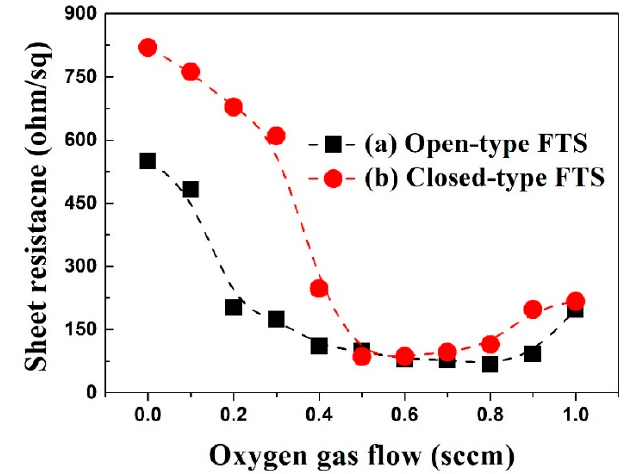
Figure 9. Electrical properties of prepared films as a function of oxygen gas flow. ( a ) Open-type FTS (OFTS) and ( b ) Closed-type FTS (CFTS). (OFTS) and ( b ) Closed-type FTS